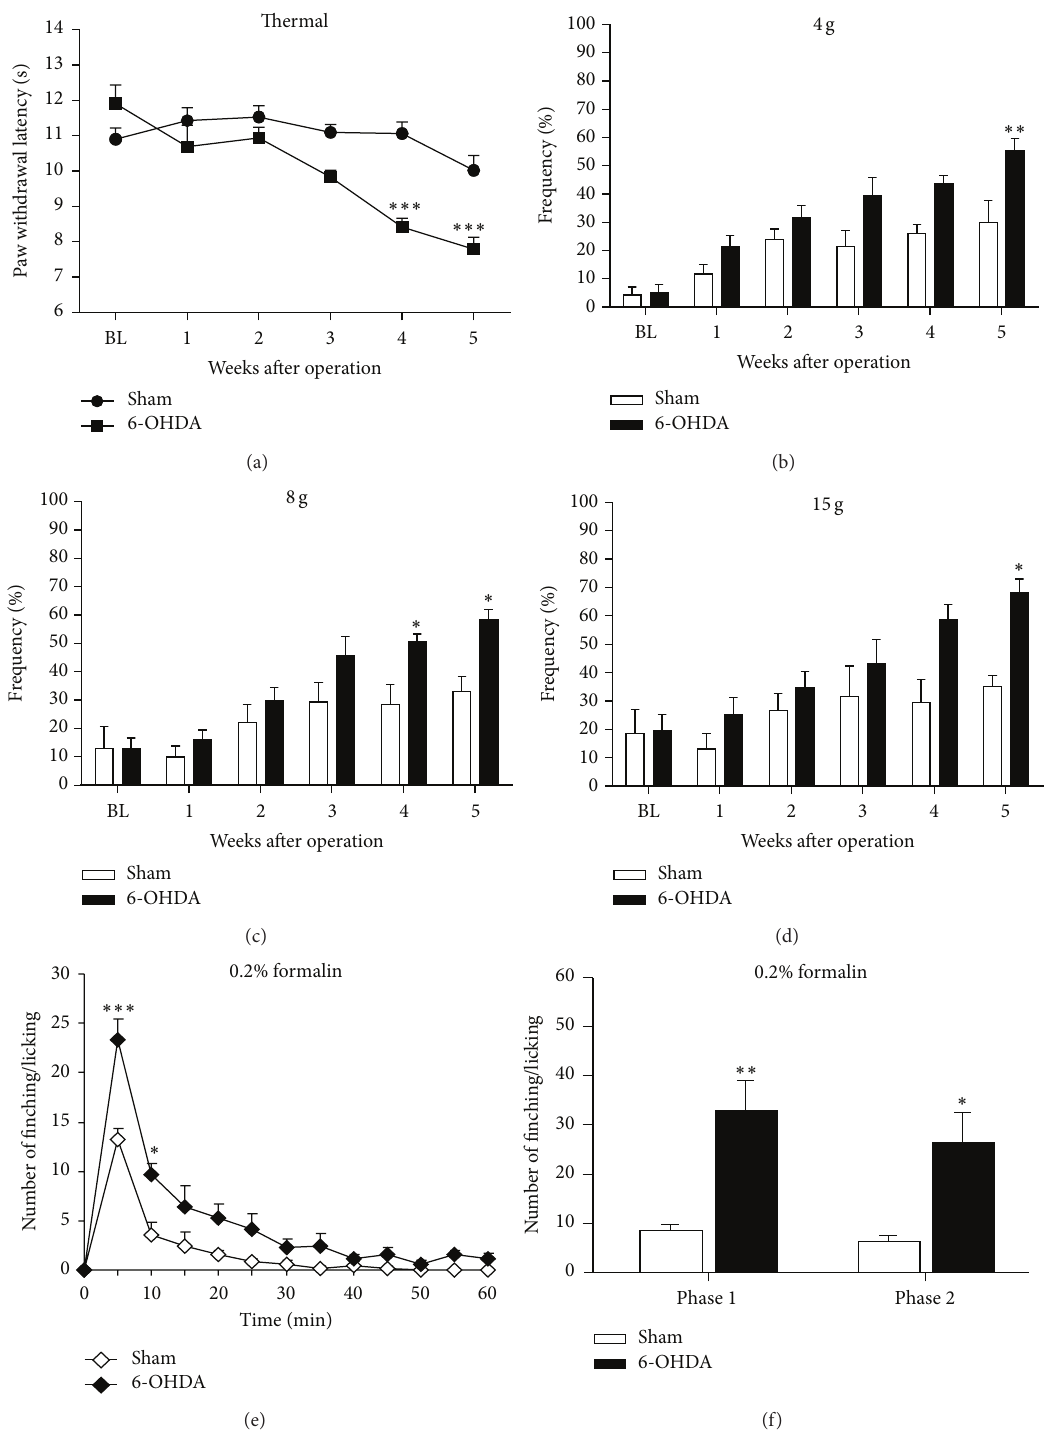
Figure 2: The development of pain hypersensitivity in the 6-OHDA-lesioned rats. After testing the baseline response to heat and mechanical stimuli, rats received a bilateral dorsal CPu injection of 6-OHDA or vehicle. (a) Paw thermal withdrawal threshold was significantly decreased in the 6-OHDA-treated rats ( 𝑛 = 12 ) than in the sham control rats ( 𝑛 = 5 ) on the 4th and 5th weeks after operation. ((b)–(d)) 4 g, 8g, and 15 g von Frey filament were used to evaluate mechanical hypersensitivity. The 6-OHDA-lesioned rats ( 𝑛 = 12 ) showed mechanical hypersensitivity from the 4th and 5th week after the 6-OHDA lesion compared with the sham rats ( 𝑛 = 5 ). ∗ 𝑃 < 0.05 , ∗∗ 𝑃 < 0.01 , and ∗∗∗ 𝑃 < 0.001 compared to the sham animals. ((e)-(f)) At the 5th week after 6-OHDA microinjection, we used the formalin test to determine the changes of chemical- induced pain. There was a significant increase in both phase 1 (0–10min) and phase 2 (10–60 min) in 6-OHDA-treated rats ( 𝑛 = 8 ) compared to the sham animals ( 𝑛 = 5 ) ( ∗ 𝑃 < 0.05 , ∗∗ 𝑃 < 0.01 , and ∗∗∗ 𝑃 < 0.001 compared to the sham